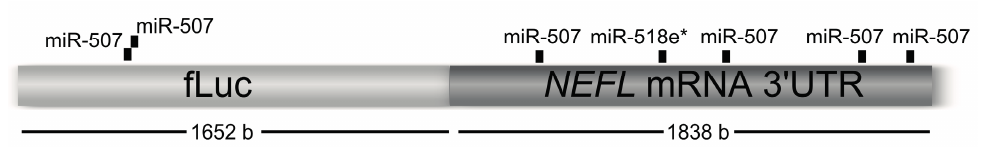
Figure 1. miRNA recognition elements (MREs) for miR-507 and miR-518e* within Firefly luciferase linked to the neurofilament ( NEFL ) mRNA